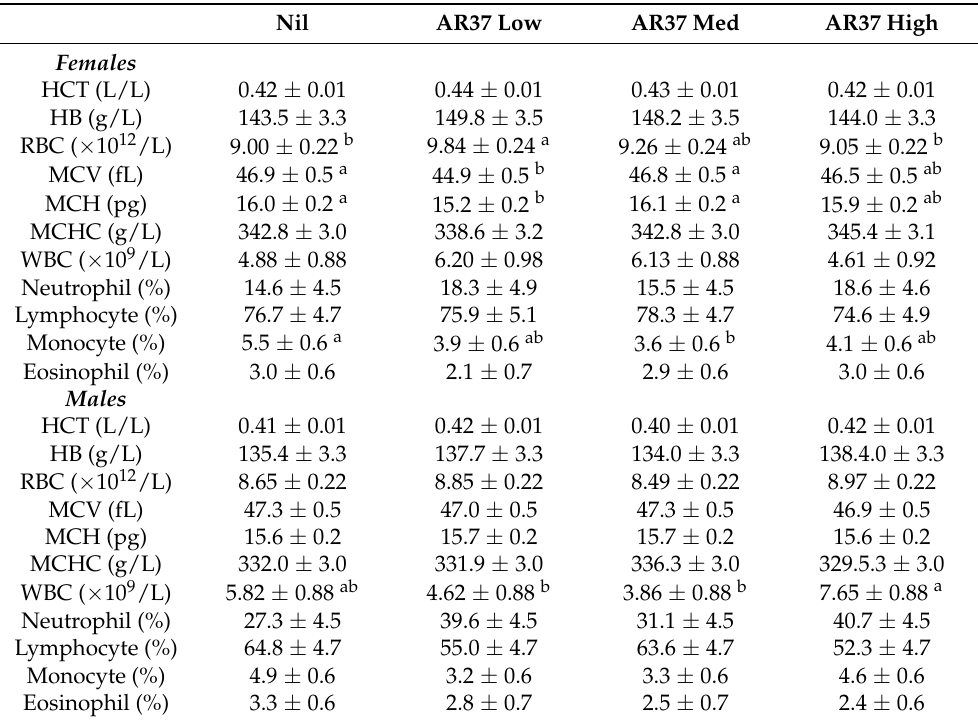
Table 5. Hematology data of mice fed nil, AR37 low, AR37 med or AR37 high diets (containing 0, 7.5, 15 or 30% endophyte-infecteed seed, respectively) for 90